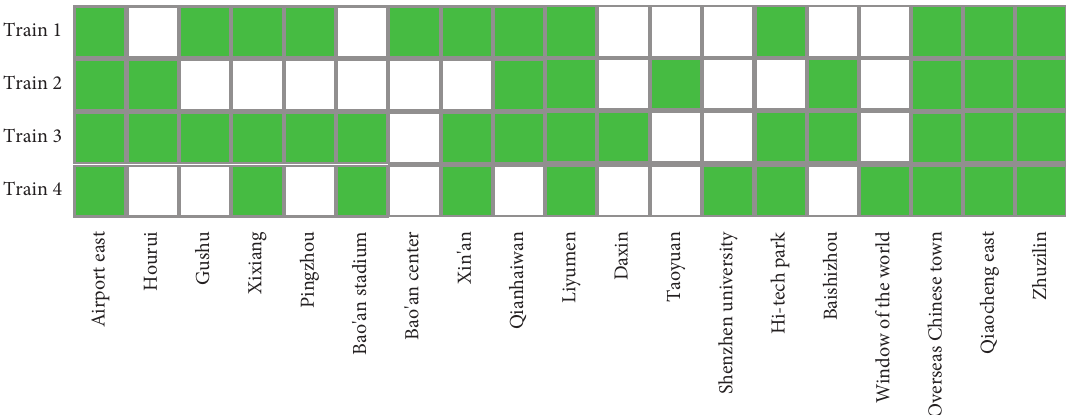
Figure 8: The solved train stop-skipping schemes for some urban metro stations on Shenzhen metro Line